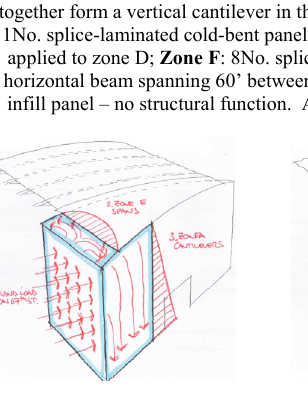
Figure 11: SS3, North/South seismic loads on the wedge are transferred into the shear